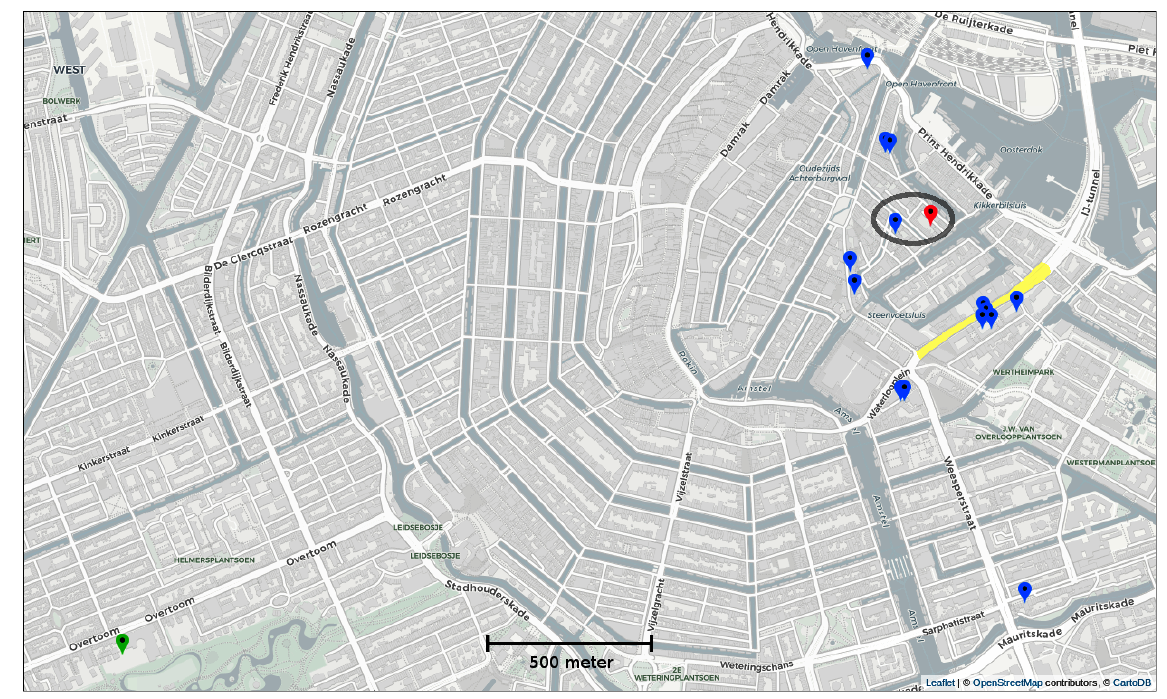
Figure 1. Locations of the sensor devices during the citizen measurement campaign. The green marker indicates the calibration location at GGD Vondelpark. In the circle the location of SD04 and the GGD station at Oude Schans (in red). The location of Valkenburgerstraat is highlighted in yellow.